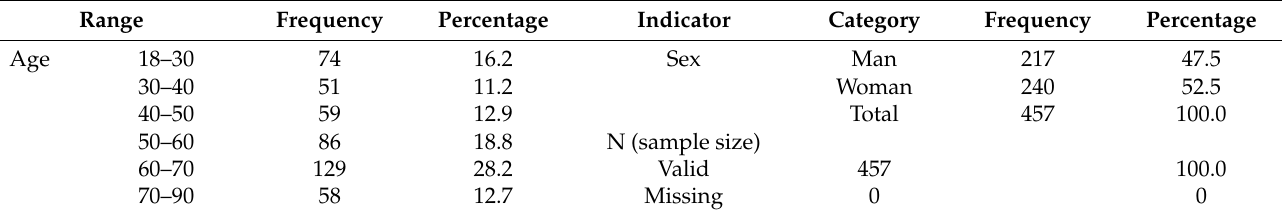
Table 1. Descriptive